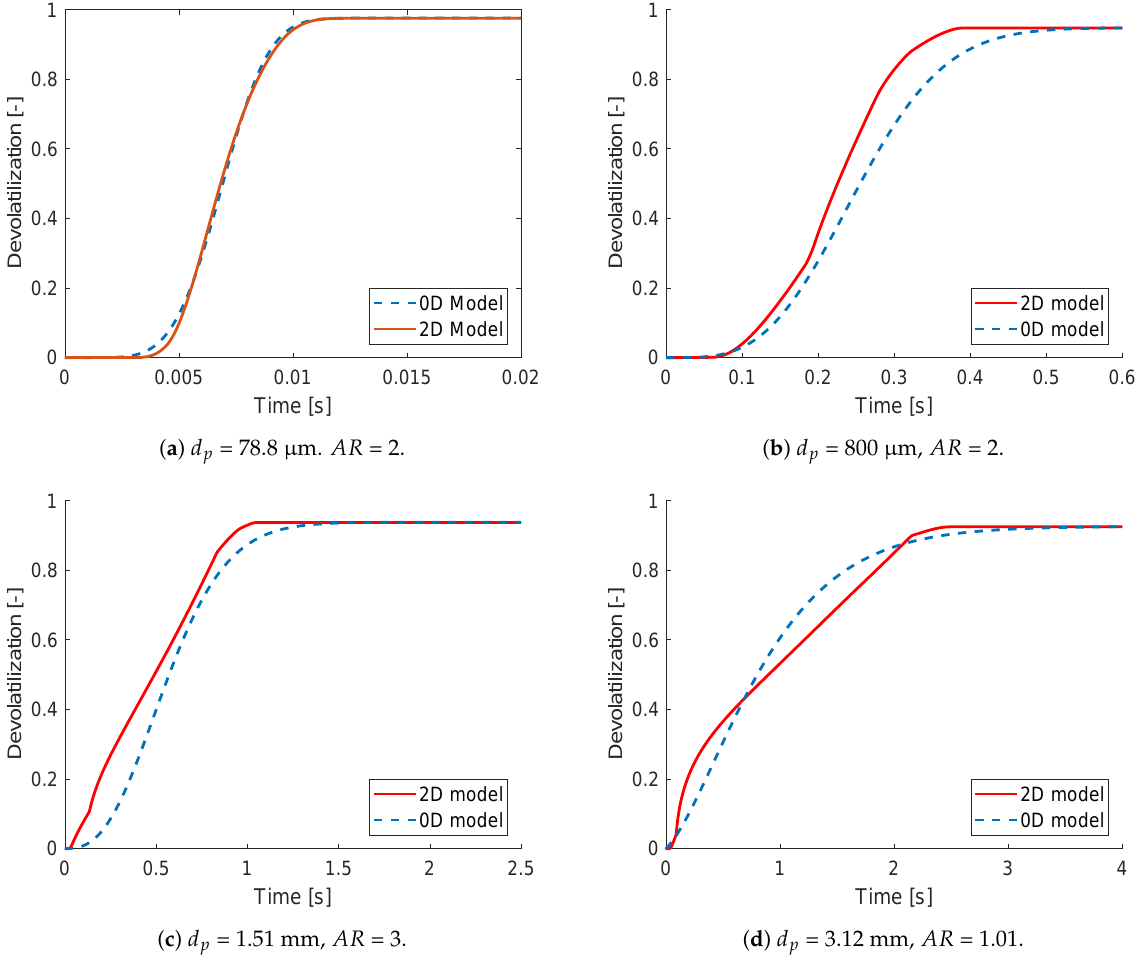
Figure 7. 0D model with the apparent kinetics modeled by the PLS model given in Equations (6) and (7) compared to a semi-2D devolatilization model [19]. ρ = 700 kg/m 3 , T g = 1600